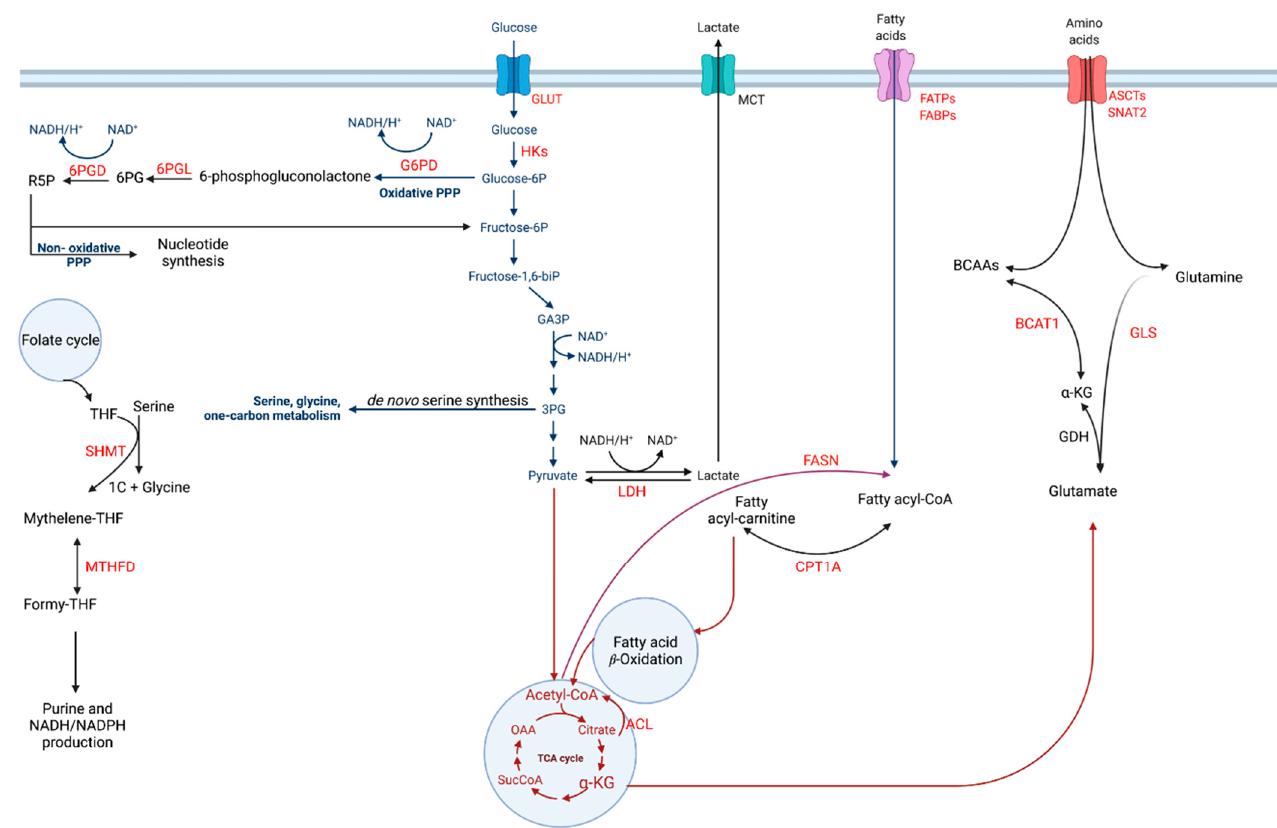
Figure 1. Schematic representation of the crosstalk between cancer-associated major metabolic pathways altered in HR+ breast cancer.